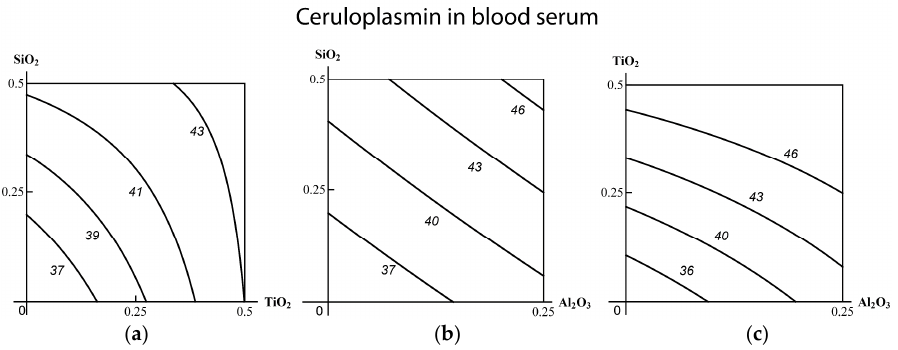
Figure 1. Combined subchronic toxicity isobolograms assessed by an increase in the concentration of ceruloplasmin in blood serum under exposure to ( а ) SiO 2 -NP + TiO 2 -NP (subadditivity); ( b ) SiO 2 -NP + Al 2 O 3 -NP (additivity); ( c ) TiO 2 -NP + Al 2 O 3 -NP (insignificant subadditivity). The axes represent doses of corresponding МеО -NPs in mg per rat; the numbers at the isoboles denote the magnitude of the effect (in mg per 100 mL). Note that the RSM-model (Response Surface Method) failed to reveal for this effect even the above-mentioned tendency towards superadditivity.